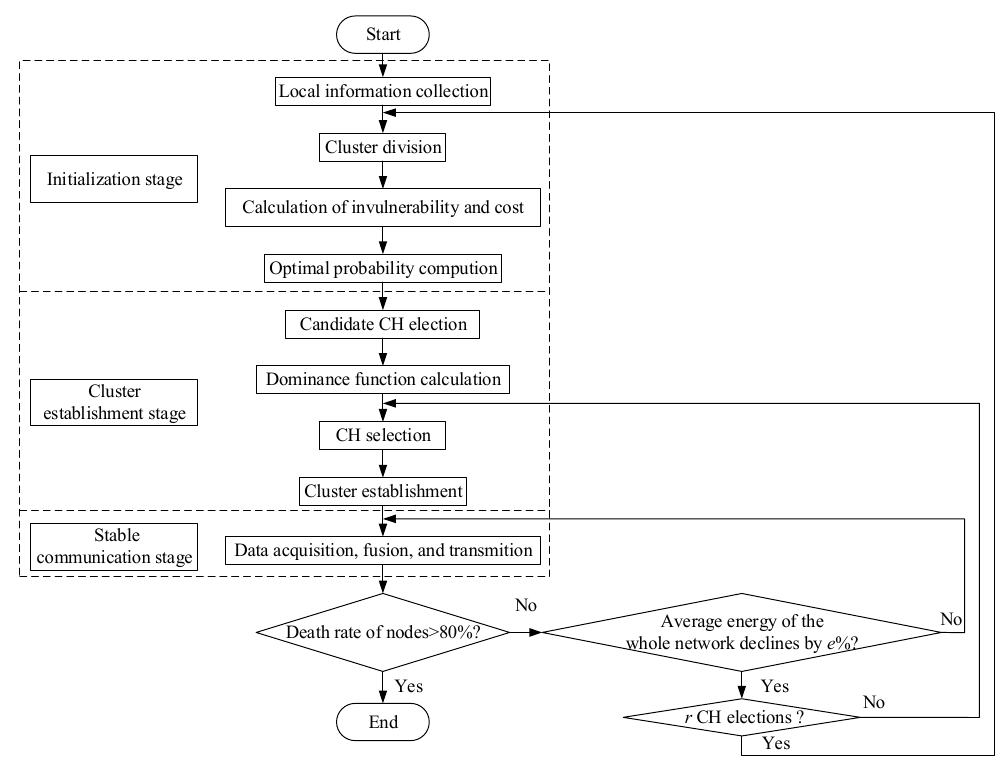
Figure 1. Flowchart of routing scheme.